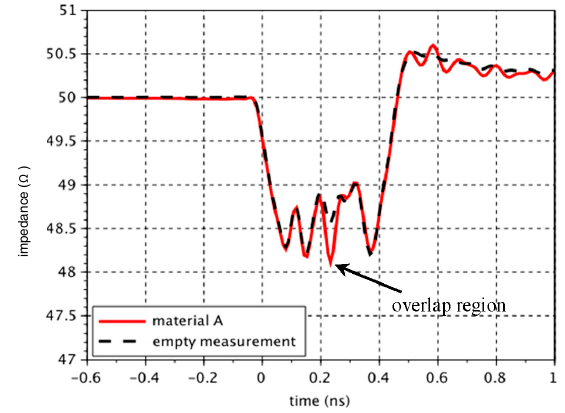
Figure 3. Planar transmission line contacts connected with ACP (Adapted with permission from [6], IEEE, 2017).